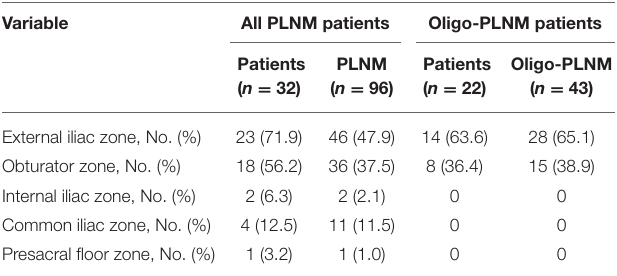
TABLE 3 | The distribution of pelvic lymph node